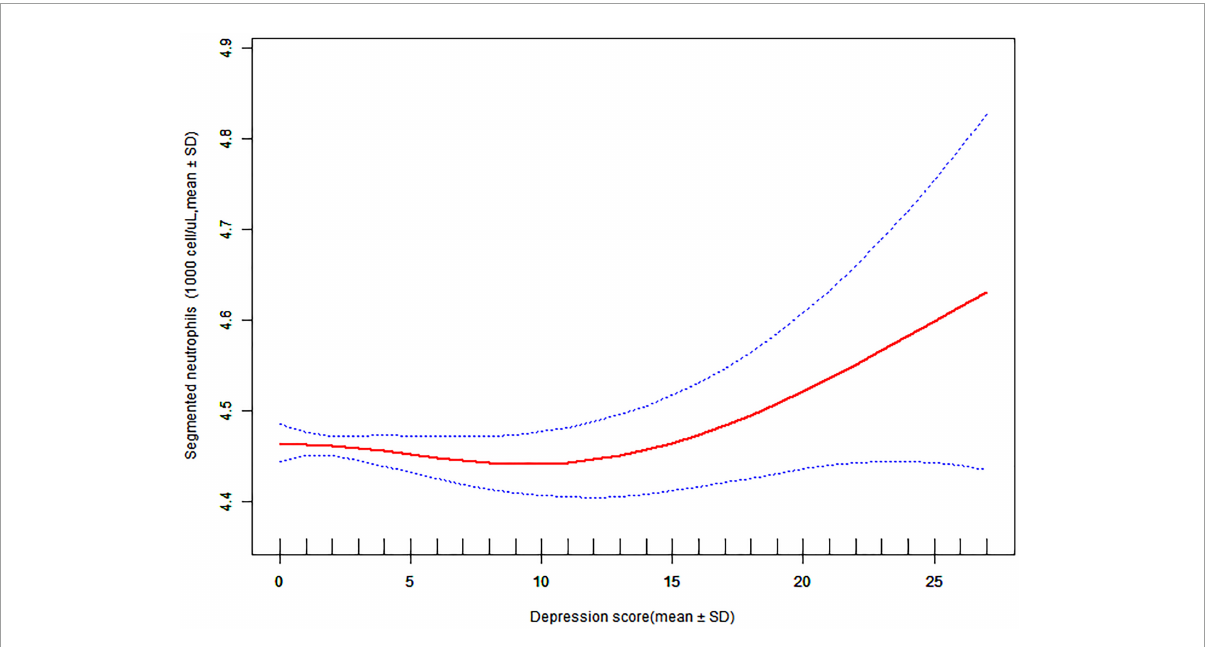
FIGURE4 Association depression score and segmented neutrophils: A threshold, non-linear association between depression severity and segmented neutrophils were found in a generalized additive model